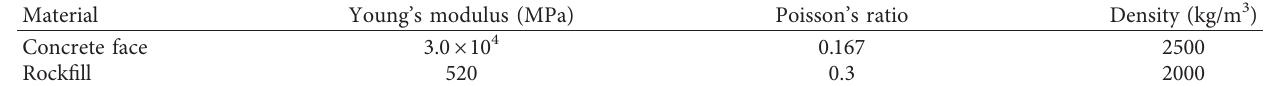
Table 3: Properties of the CFRD.